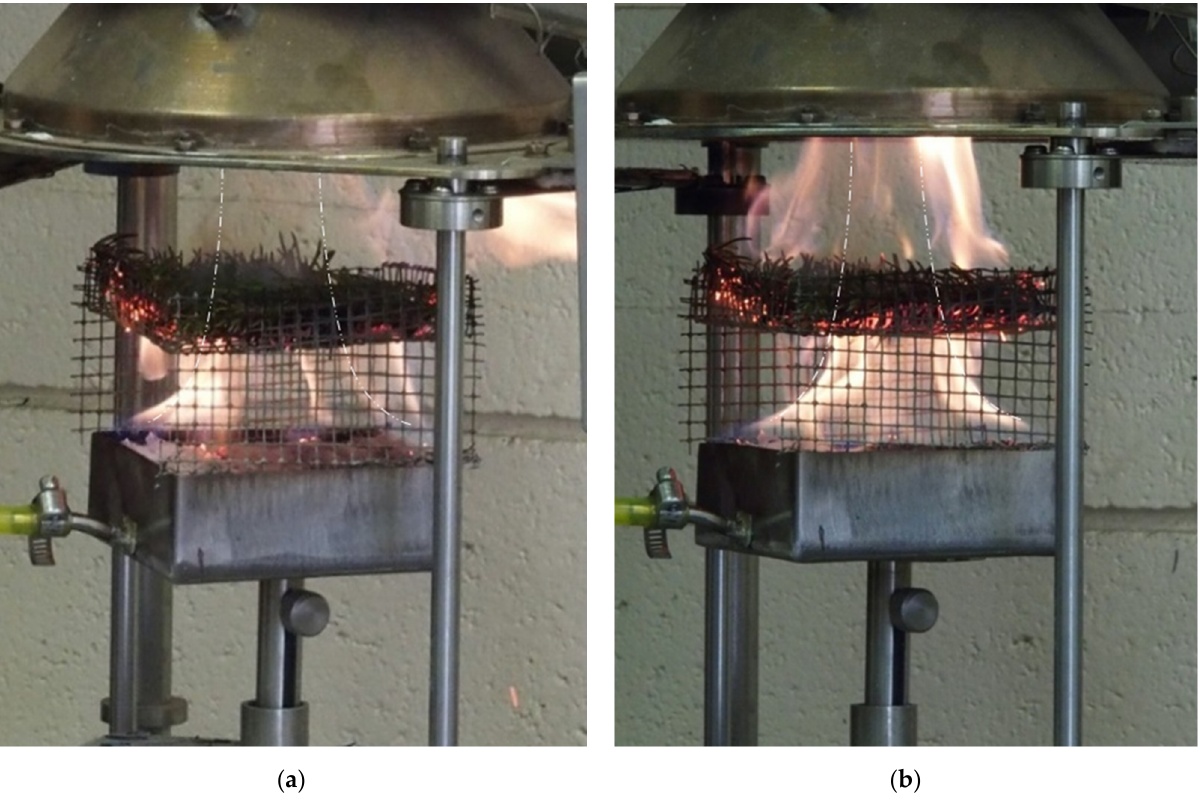
Figure 5. Variation in energy release contribution depending on fuel properties. For ( a ) new shoots with high water content, the combined energy release of the incoming methane flame interacting with burning live fuel was lower (both when measured and when judged visually by the volume of flames) compared with the initial energy release of the incoming methane flame alone (indicated by white dashed line). Therefore, the live fuel sample’s contribution to the energy release of the incoming methane flame expressed as ∂ H eff was negative. In the case of ( b ) highly flammable 1 year-old shoots, the ∂ H eff was positive, where the combined volume (and hence energy release) of the incoming methane flame interacting with burning live fuel was larger compared to that of the incoming methane flame alone (indicated by white dashed line).